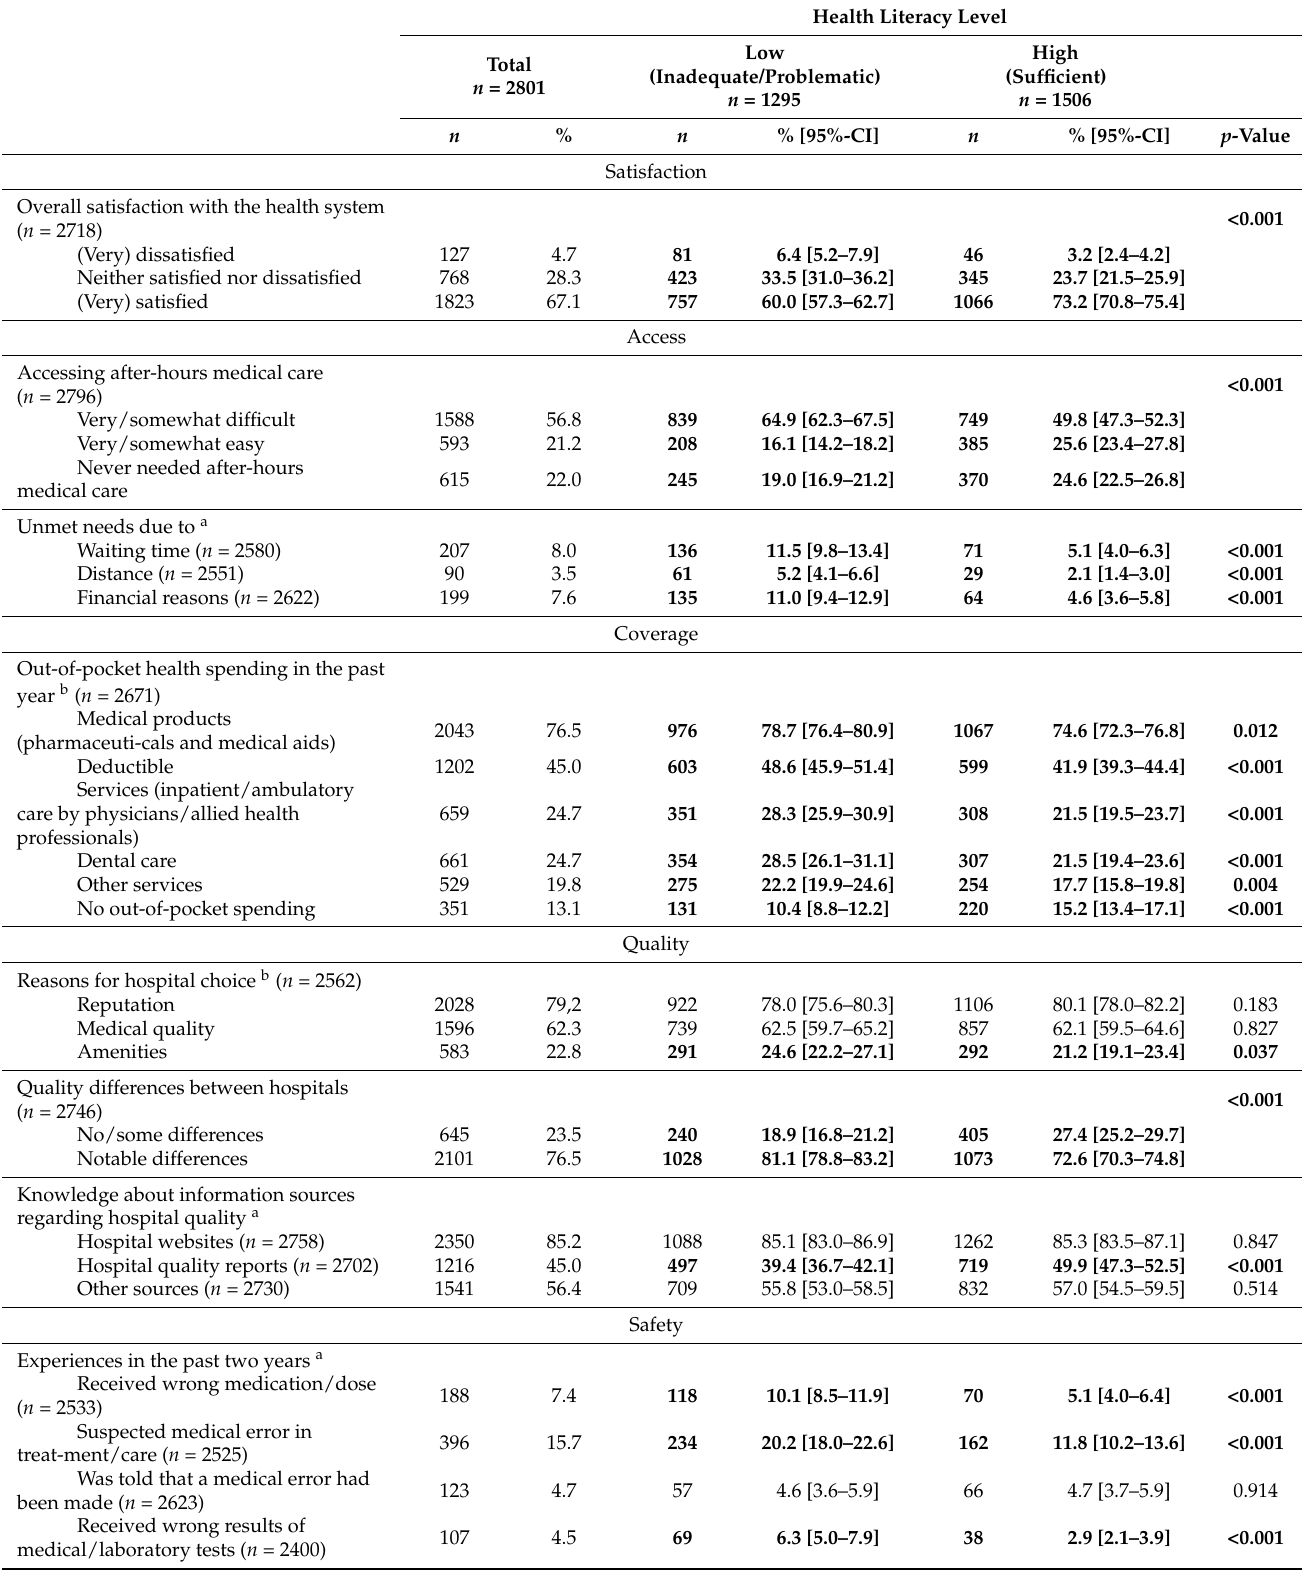
Table 4. Assessment of the health system performance from the PHI insureds’ perspective, total and stratified by health literacy levels ( n =